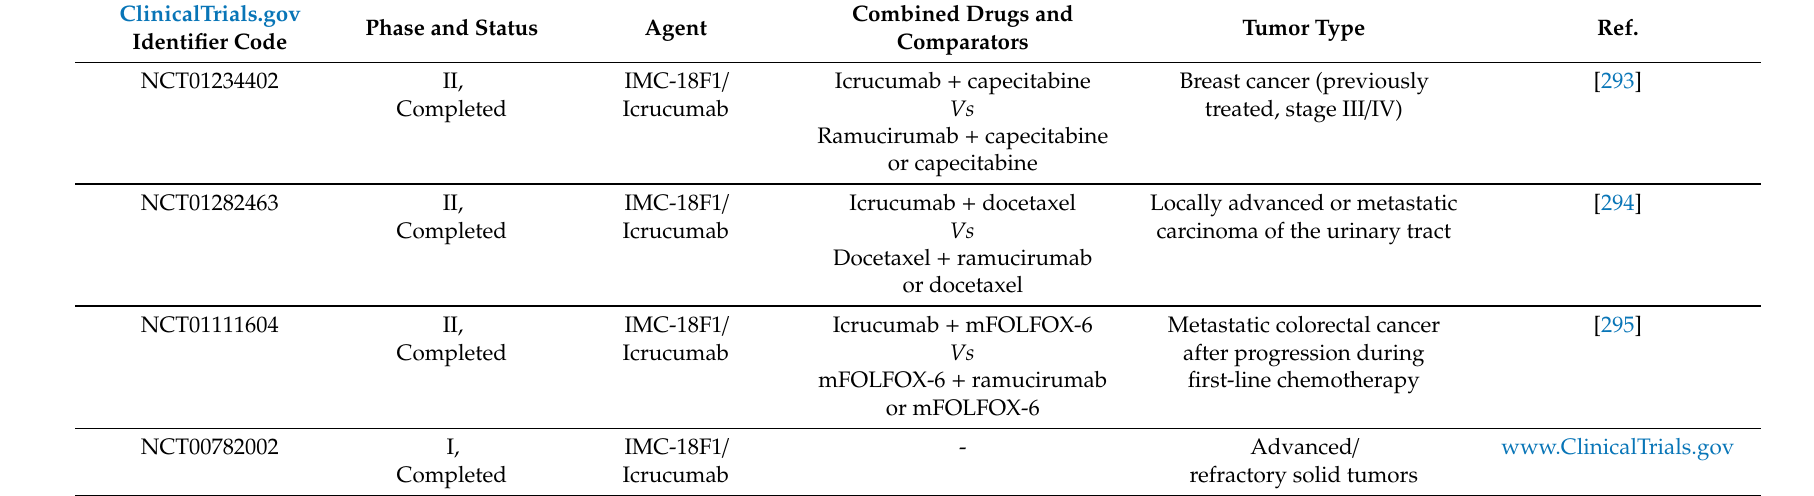
Table 5. Clinical trials involving selective VEGFR-1 signaling